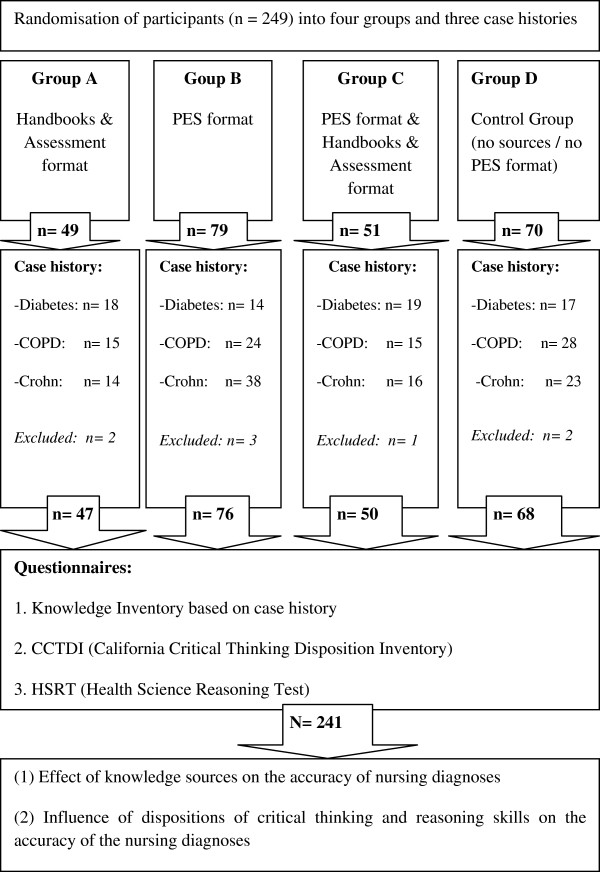
Research design.